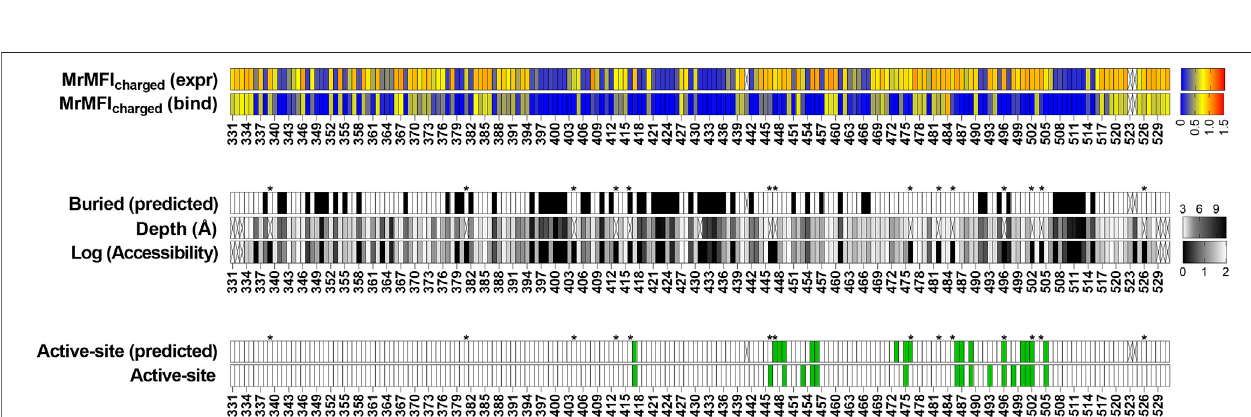
FIGURE 7 | Prediction of buried and active-site positions in SARS-CoV-2 RBD from Sortseq data. Buried residues were identi fi ed from chain C of PDB ID 7KMH, residues which had < 10%side chain accessibilitywerecategorized asburied. The accessibility and depth was calculated using DEPTH server (Tan et al., 2011).Active- site residues were identi fi ed from PDB ID 6M0J as explained earlier (Malladi et al., 2021). Criteria used to predict buried and active-site positions from MFI data were identicaltothoseusedforCcdB.PositionswhichdidnothaveMrMFIdataorcouldnotbeassignedtoeitherburiedoractive-sitecategoriesarehighlightedwith “ X ” . Accessibility calculated by DEPTH server for glycine is zero and these are marked with a “ * ”